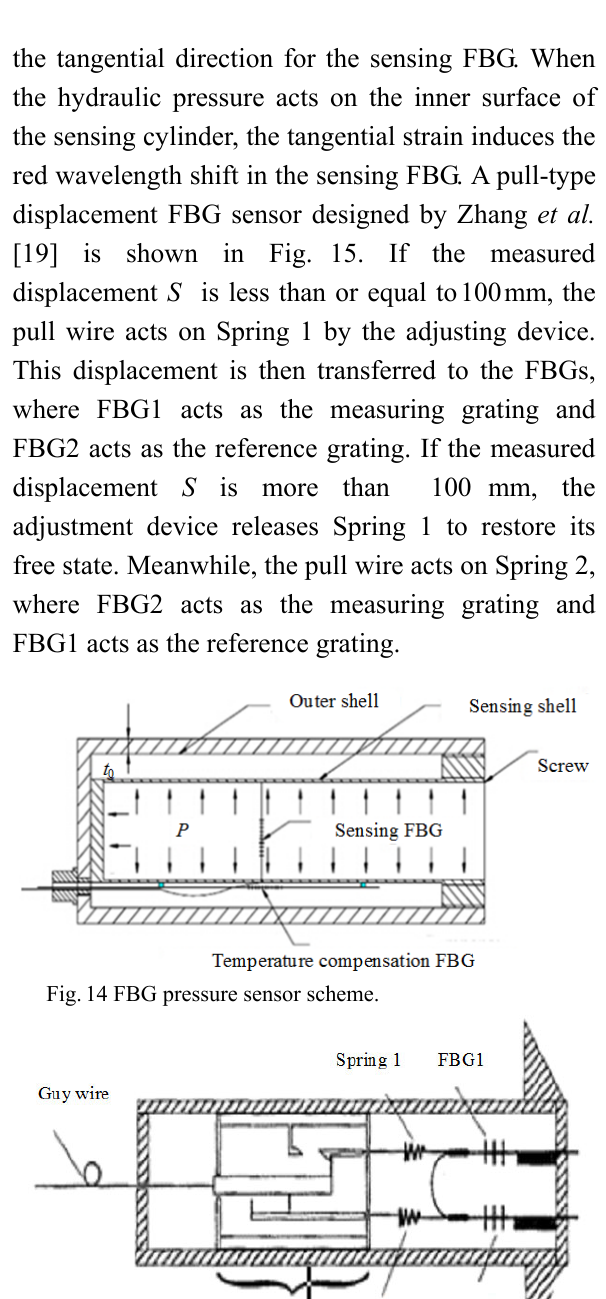
Fig. 14 FBG pressure sensor scheme.